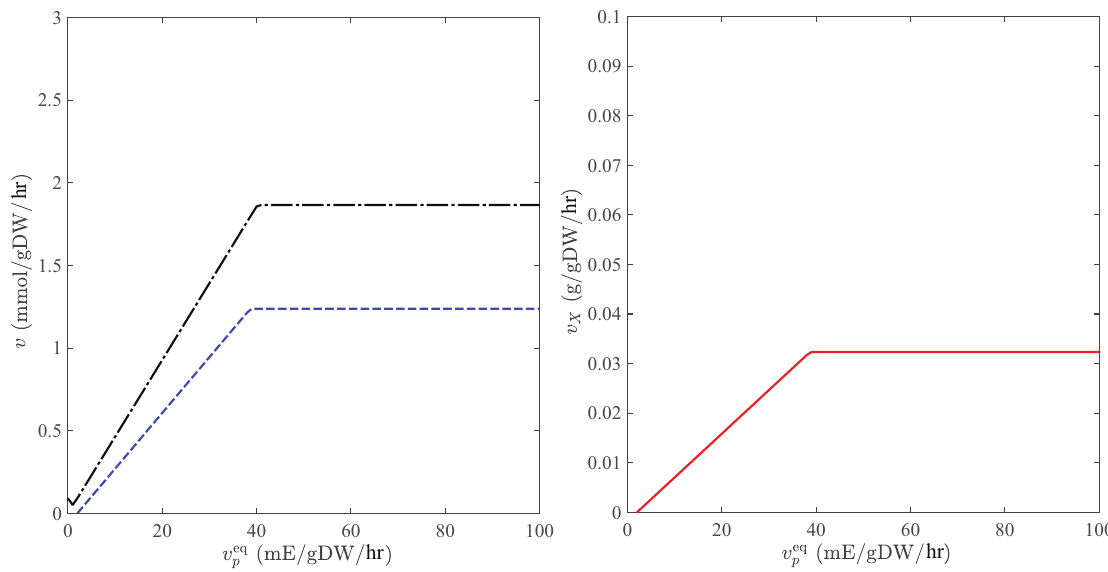
Figure 4. Metabolic fluxes in the autotrophic mode when CO 2 is the only carbon source. Left panel: consumption rate of CO 2 (dashed) and production rate of O 2 (dashed-dotted); Right panel: production rate of biomass. Equilibrium concentrations of O 2 and CO 2 are determined for a flue-gas stream that is fed into the pond at 0.5 atm and using Henry’s constants K H ,CO to estimate uptake